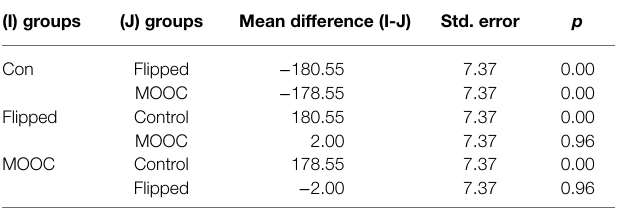
TABLE 7 | Post-hoc Scheffe test, multiple comparisons (motivation post-tests).